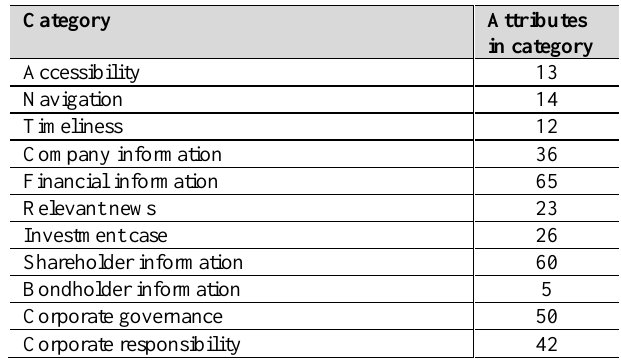
Table 2: Categories used and attributes per